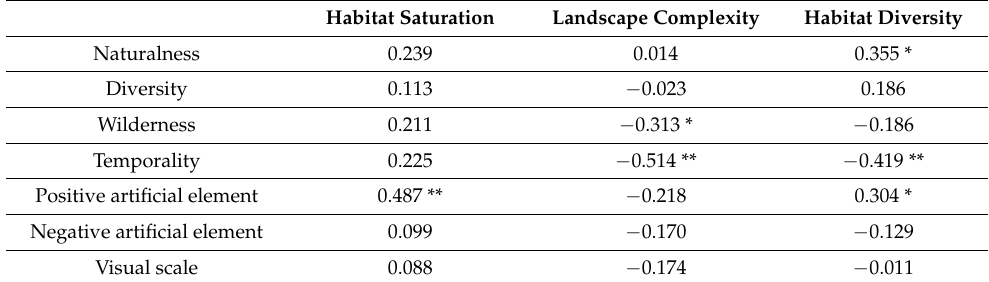
Table 5. The correlation between the habitat diversity of the samples and the measure of visual preference